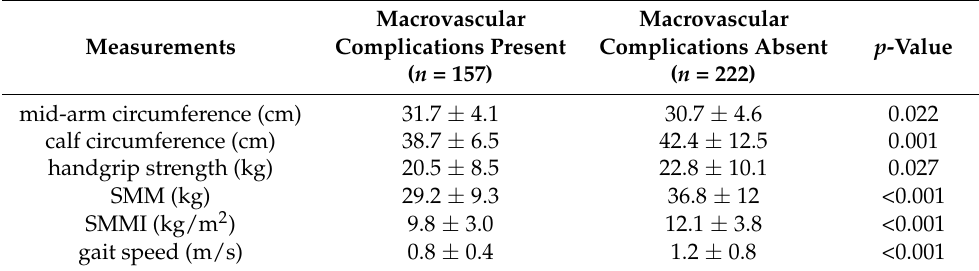
Table 3. Results of sarcopenia assessments.